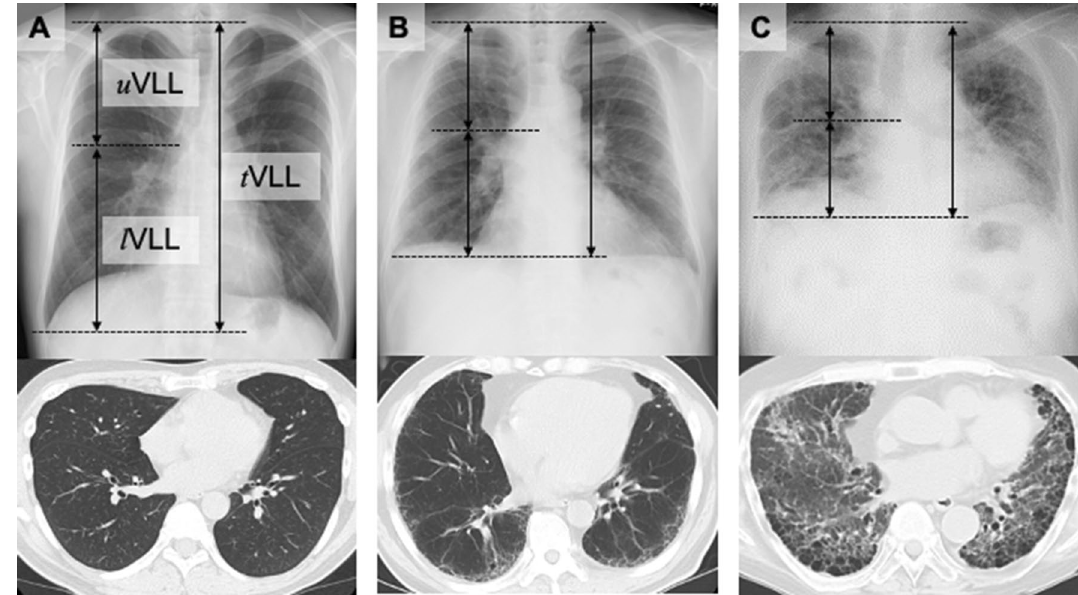
Figure 2. Measurements of vertical lung length (VLL) on chest X-rays. Three VLL measurements were taken: upper VLL ( u VLL), from the apex to the costophrenic angle; lower VLL ( l VLL), from the tracheal carina to the costophrenic angle; and total VLL ( t VLL), from the apex to the costophrenic angle. Measurements were performed in the right lung. Compared with control subjects ( A ), patients with mild interstitial pneumonia (IIP) ( B ) and severe IIP ( C ) demonstrated decreased u VLL, l VLL, and t VLL. The decrease in l VLL was especially The AUC for l VLL was significantly higher than those for uVLL ( p < 0.001), t VLL ( p = 0.030), and l / u VLL ratio ( p < 0.001). There was no significant difference in AUCs between t VLL and l / u VLL ratio. When limited to patients with mild IIPs, the final cut-off values in the total cohort were 103 mm/m for l VLL (sensitivity 0.66, specificity 0.78, AUC 0.79), 164 mm/m for t VLL (sensitivity 0.63, specificity 0.76, AUC 0.74), and 1.70 for l / u VLL ratio (sensitivity 0.70, specificity 0.75, AUC 0.78) (Fig. 5I–L). The AUC for l VLL was significantly higher than those for u VLL ( p < 0.001) and t VLL ( p < 0.001). There was no significant difference in AUCs between l VLL and l / u VLL ratio, or between t VLL and l / u VLL ratio. When using the VLL cutoff values in round numbers in clinical practice, an lVLL of 100 mm/m had a sensitiv- ity of 0.71 and specificity of 0.86 for all IIPs, and a sensitivity of 0.54 and specificity of 0.86 for mild IIPs. A tVLL of 160 mm/m had a sensitivity of 0.70 and specificity of 0.83 for all IIPs, and a sensitivity of 0.49 and specificity of 0.83 for mild IIPs. An l/uVLL ratio of 1.70 had a sensitivity of 0.76 and a specificity of 0.75 for all IIPs, and a sensitivity of 0.70 and specificity of 0.75 for mild IIPs. Correlations of VLLs with clinical factors and findings of chest computed tomography. The t VLL and l VLL showed moderate positive correlations with %predicted FVC ( r = 0.63 and 0.60, respectively) and %predicted forced expiratory volume in 1 s (FEV 1 ) ( r = 0.54 and 0.53, respectively), and weak inverse correla- tions with body mass index (BMI) ( r = − 0.31 and − 0.29, respectively) and FEV 1 /FVC ratio ( r = − 0.27 and − 0.23, respectively) (Table 3). The u VLL and l / u VLL had weak positive correlations with %predicted FVC ( r = 0.30 and 0.41, respectively) and %predicted FEV 1 ( r = 0.22 and 0.38, respectively), and weak inverse correlations with FEV 1 /FVC ratio ( r = − 0.21 and − 0.10, respectively). The uVLL was negatively associated with the extent of the reticular pattern, but not with honeycombing or GGO ( p = 0.011, 0.744, and 0.564, respectively) (Fig. 6A–C). lVLL, tVLL, and l/uVLL were negatively associated with the extent of the reticular pattern (all p < 0.001), hon- eycombing ( p < 0.001, 0.003, and < 0.001, respectively), and ground-glass opacity (GGO) on chest computed CT images ( p = 0.021, 0.022, and 0.039, respectively) (Fig. 6D–L). The patients with honeycombing (n = 190) had significantly lower lVLL, tVLL, and l/uVLL values than those without (n = 90) ( p = 0.005, 0.020, and 0.001, respectively). When compared with the controls, both patients with and without honeycombing had significantly lower uVLL ( p = 0.003 and 0.006, respectively), lVLL (both p < 0.001), tVLL (both p < 0.001), and l/uVLL (both p < 0.001) values. Percentage low-attenuation area (%LAA), defined by the percentage area below − 950 HU in the total lung area on chest CT images had weak positive correlations with uVLL, lVLL, and tVLL (r = 0.24, 0.38, and 0.34, respectively) and a very weak correlation with the l/uVLL (r = 0.19) (Table 3). After adjusting for age, sex, BMI, %predicted FVC, %predicted FEV 1 , and %LAA in multivariate analyses, l VLL, t VLL, and l / u VLL ratio were identified as independent predictive factors for the detection of IIPs and mild IIPs (Tables 4 and 5). Subgroup analysis of patients with IPF and non‑IPF.